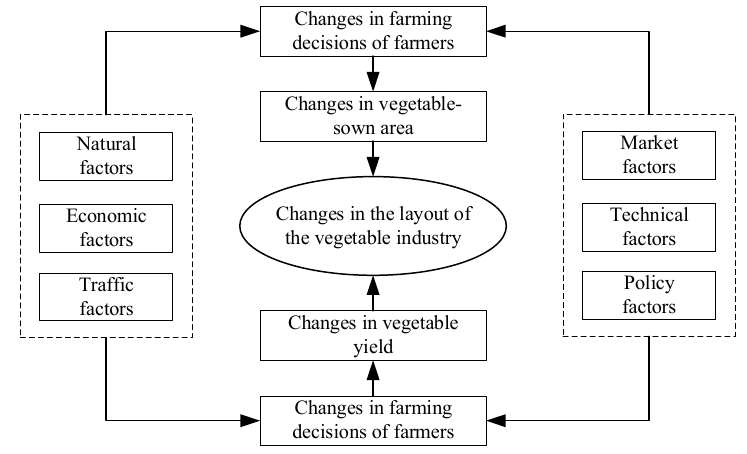
Figure 1. Research